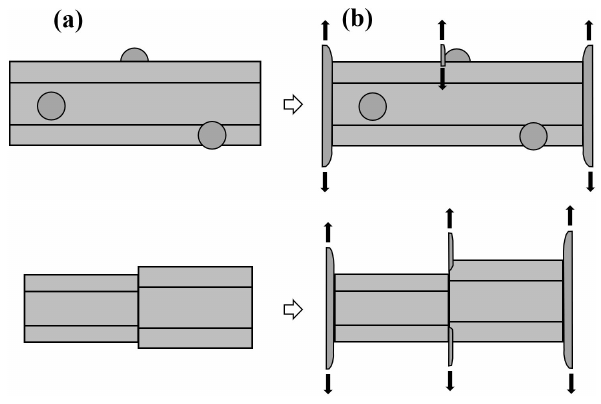
Figure B6. Protruding growth leading to multiple-capped column crystals. (a) A columnar crystal either with rime droplets (top) or some sort of break feature (bottom). (b) Moving into a tabular- growth temperature leads to protruding tabular growth. Black ar- rows in rime case show that the protruding growth extends outwards in all directions within the